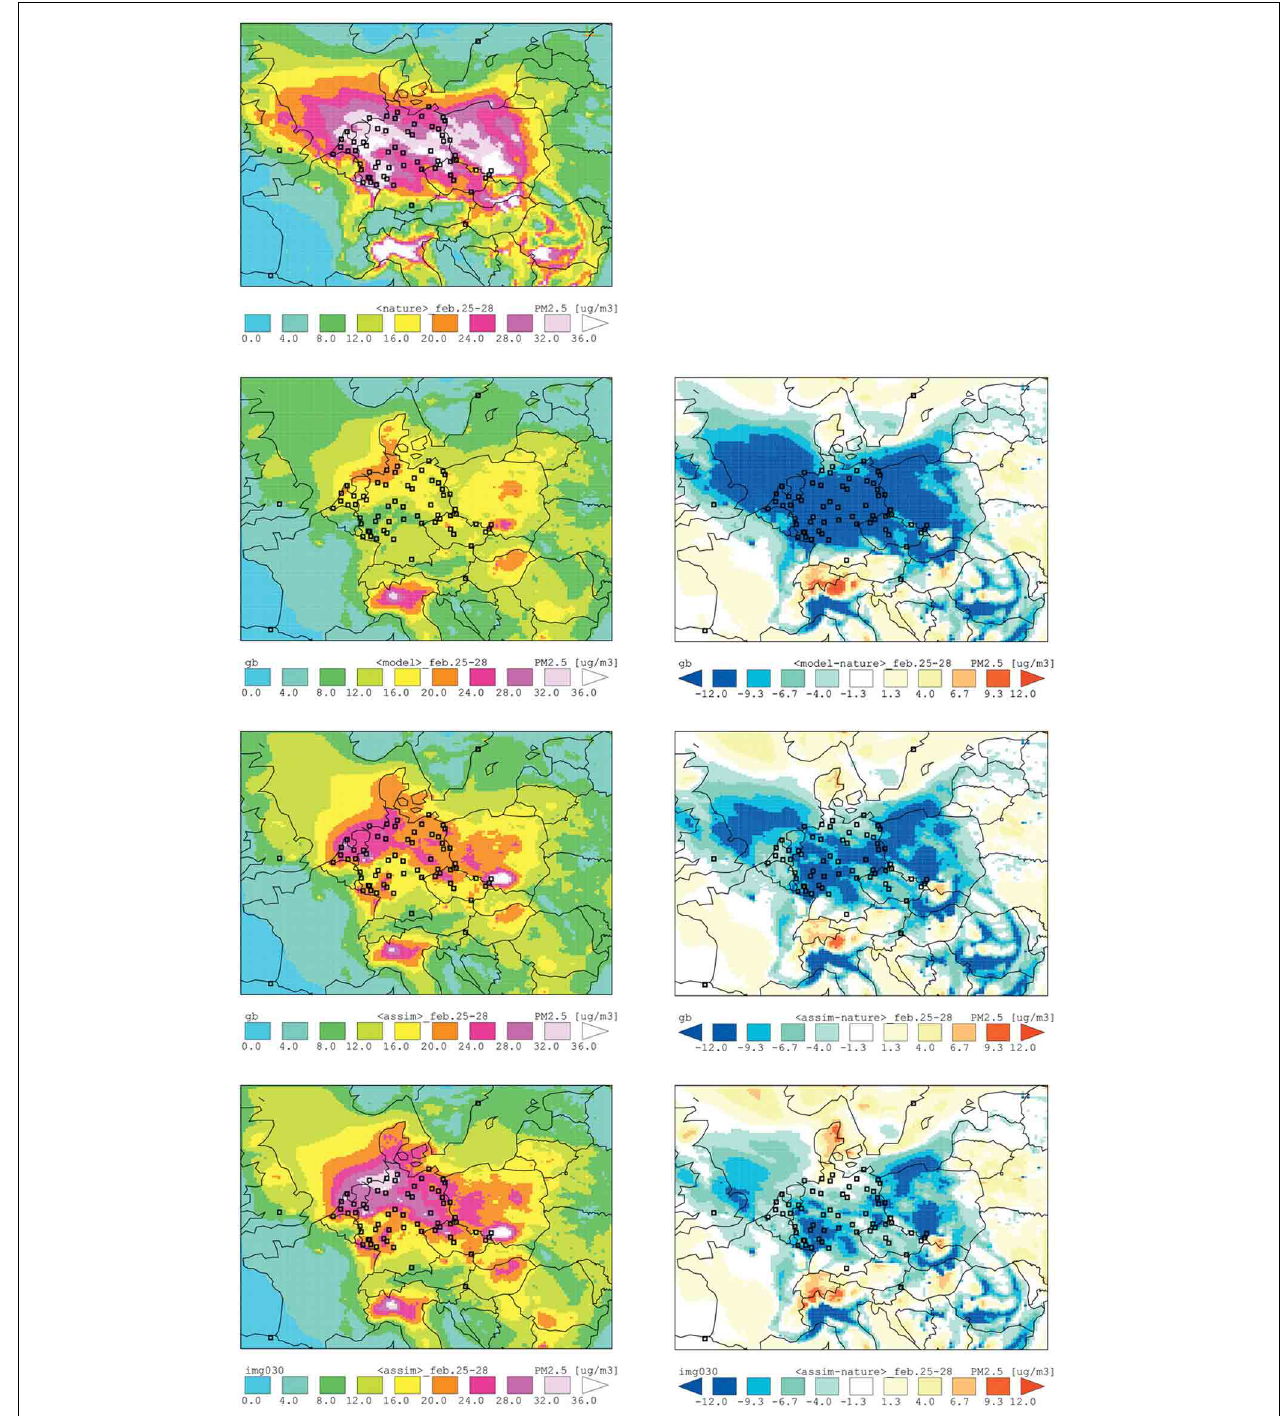
FIGURE 6 | Results from an OSSE performed to test the addition of column AOD (aerosol optical depth) measurements from a prospective geostationary (GEO) satellite. Plots use fields of particulate matter of radius less than 2.5 micrometers, PM2.5, units of µ gm − 3 , and are averages over the period 25–28 February 2003. The panels show the following. Top row: Nature Run. Second row: left, model run, i.e., without data assimilation; right: difference, model minus Nature runs. Third row, left: assimilation run #1 incorporating synthetic ground-based PM2.5